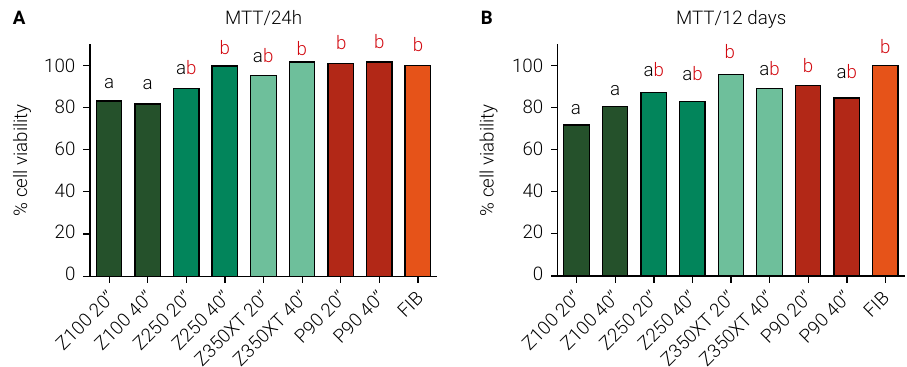
Figure 3. Percentage gingival fibroblast viability after incubation with composite extracts after (A) 24 hours or (B) 12 days. (FIB = fibroblasts; the same letters indicated similar